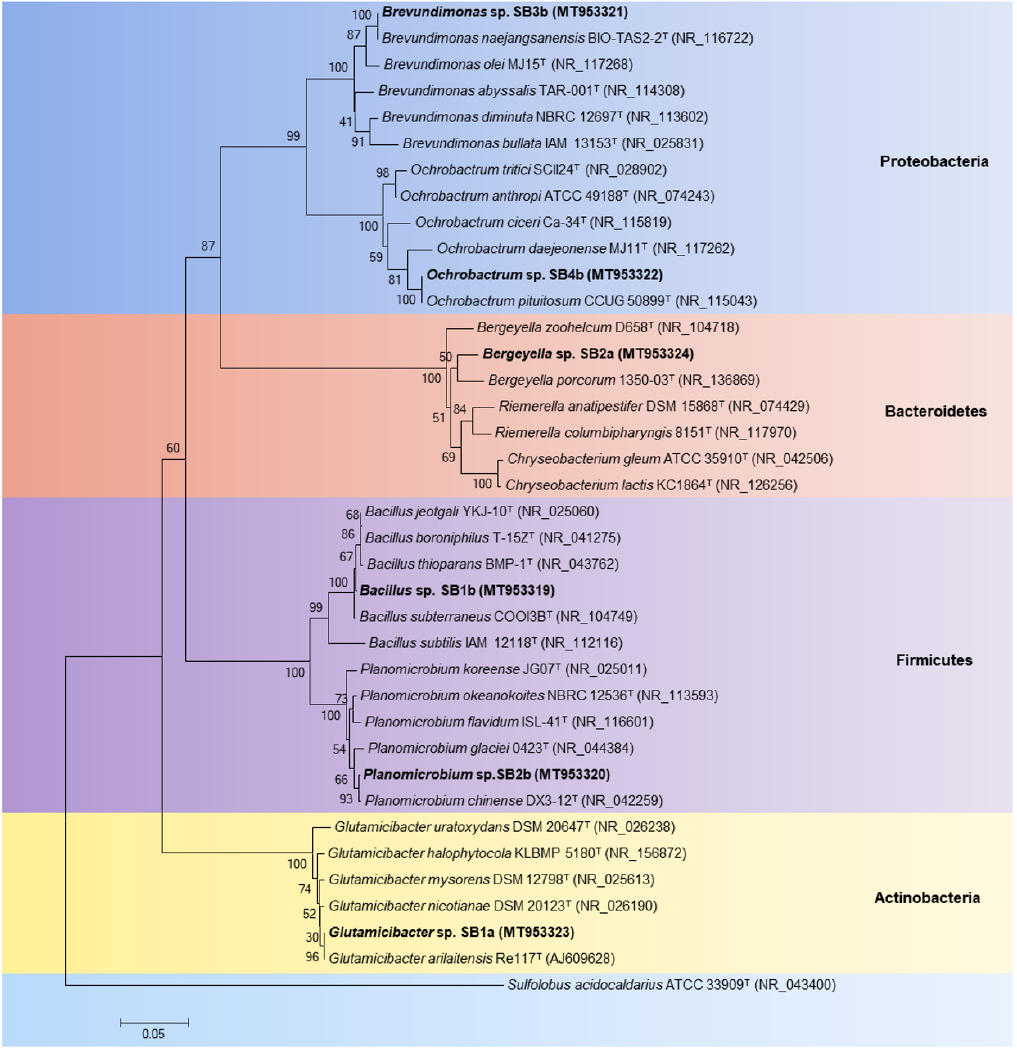
Figure 5. Identification by 16S rRNA gene sequence analyses of mercury-tolerant bacterial strains from bioremediated agricultural soil. The phylogenetic tree was constructed using Neighbor-joining method. The tree has arbitrarily been rooted by the archaeon Sulfolobus acidocaldarius . Values of 1000 bootstrap are informed at the branching point. GenBank accession numbers of 16S rRNA sequences are indicated in parentheses. Scale bar represents 0.05 substitutions per nucleotide positions.